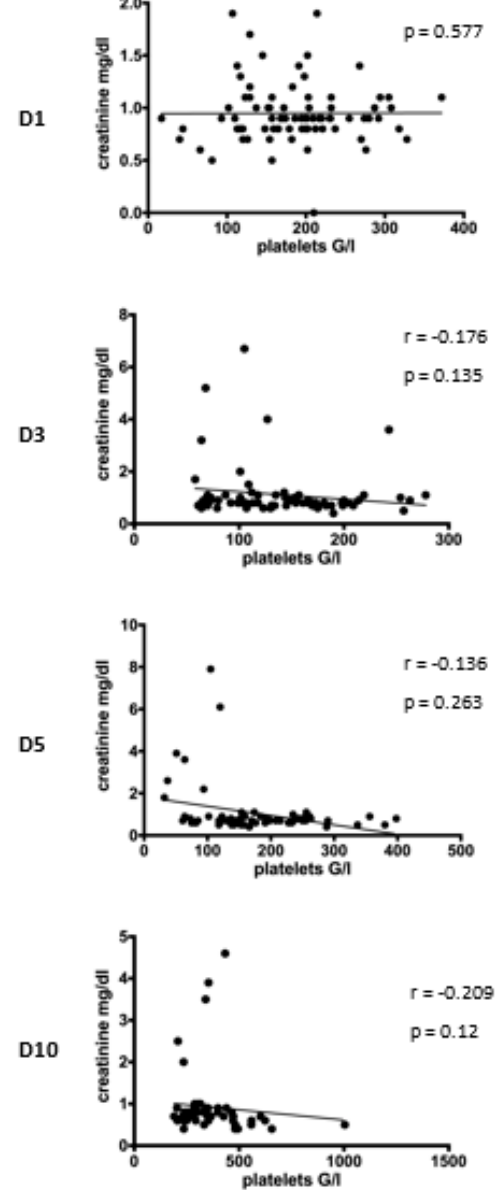
Figure 4. Correlation between platelet count and creatinine concentration following injury. Correlation analysis at D1 after admission reveals no correlation between platelet count and creatinine concentration (r = 0.063, p = 0.577). On the subsequent days, there is a slight trend that thrombocytosis is associated with decreased creatinine concentration (D3: r = − 0.176, p = 0.135; D5: r = − 0.136, p = 0.263; D10: r = − 0.209, p = 0.12). D = day, r= Pearson/Spearman’s correlation coefficient, p = level of